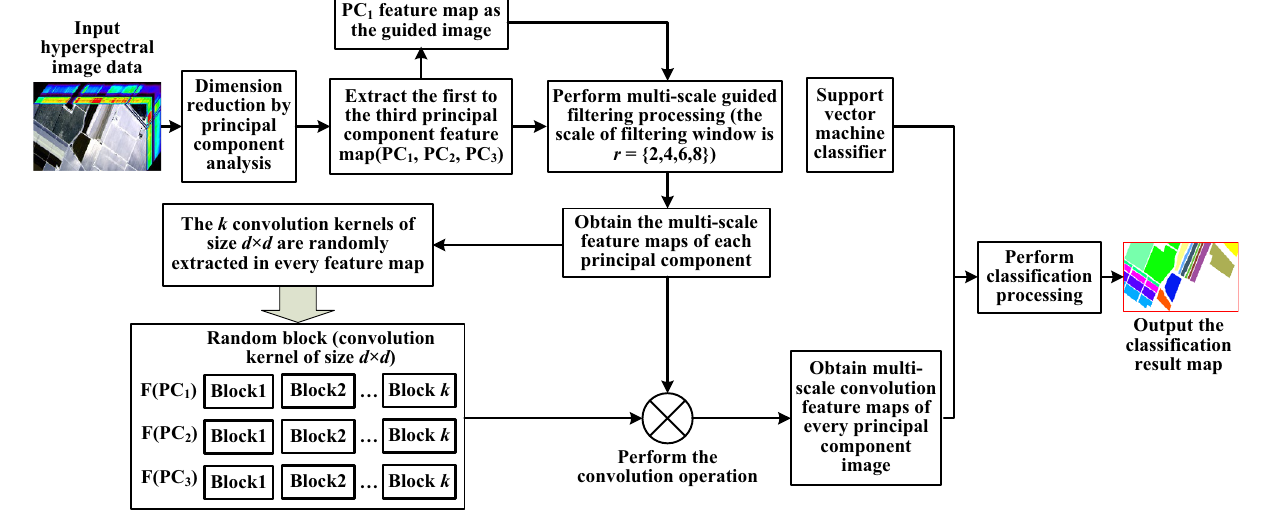
Figure 1. Schematic diagram of MGFEC